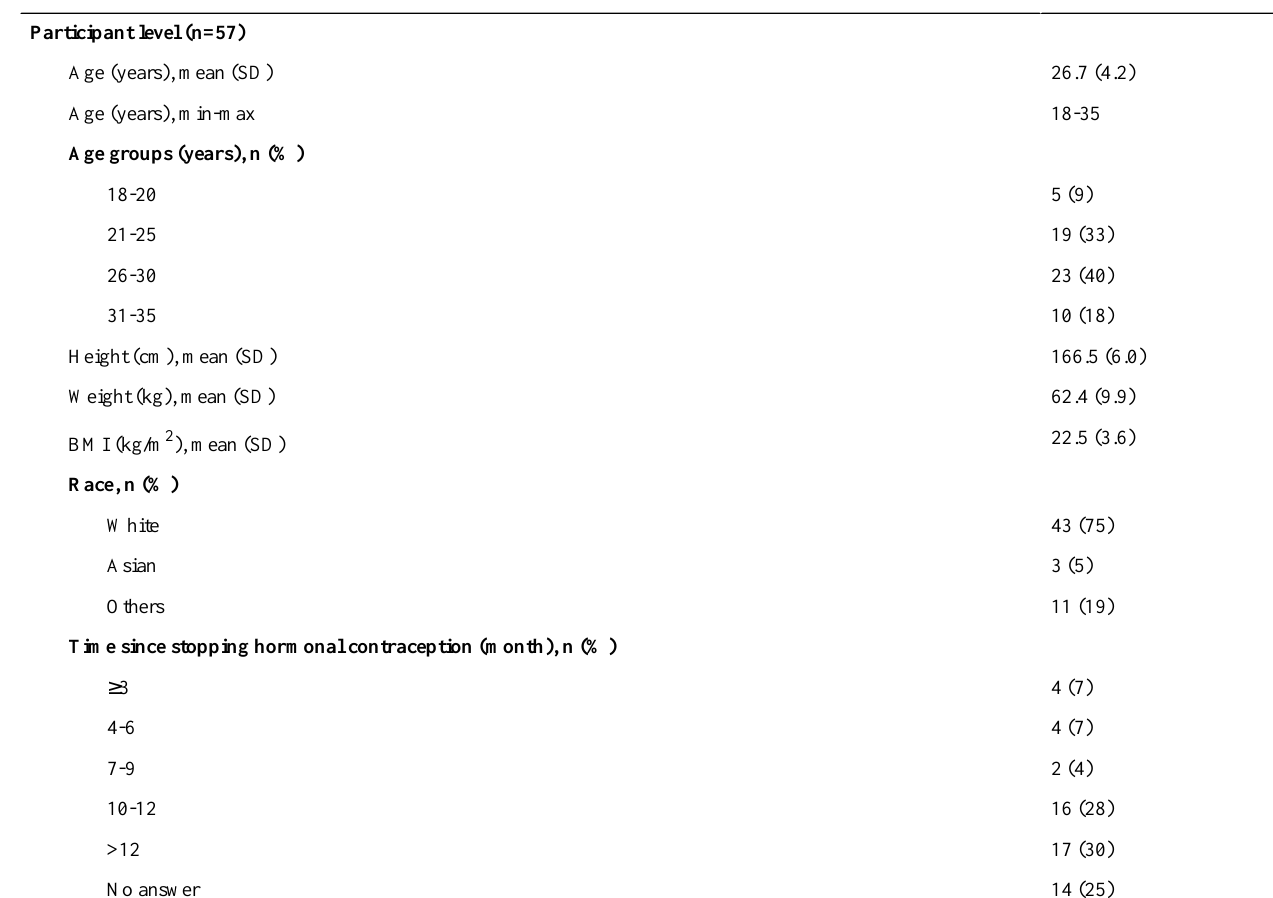
Table 1. Characteristics of the participants and their